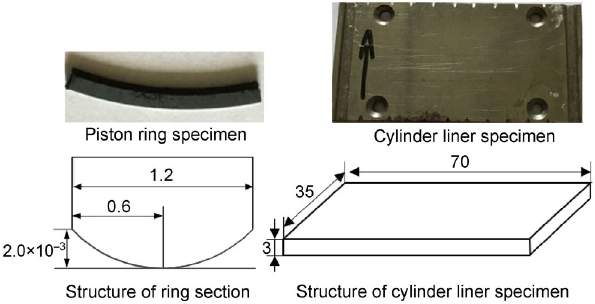
Fig. 1 Samples and structure of piston ring and cylinder liner.